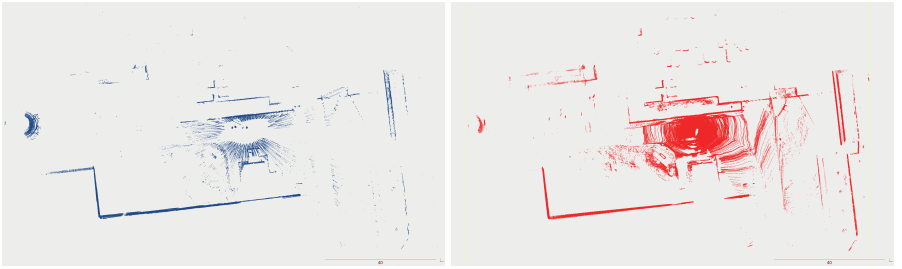
Figure 10. Undistorted, aggregated point clouds were built using data from the Livox Mid–40 with the rotated reflector (blue) and Velodyne VLP 16 (red) at Zwentendorf NPP. Top down view of Figure